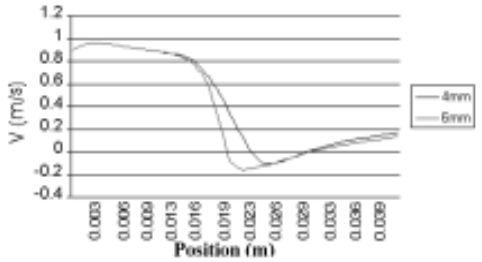
Fig. 11 - Velocity profile, which enables identification of the existence of recirculation in simulated flows. Note that the recirculation is greatly influenced by the diameter of the PTFE graft